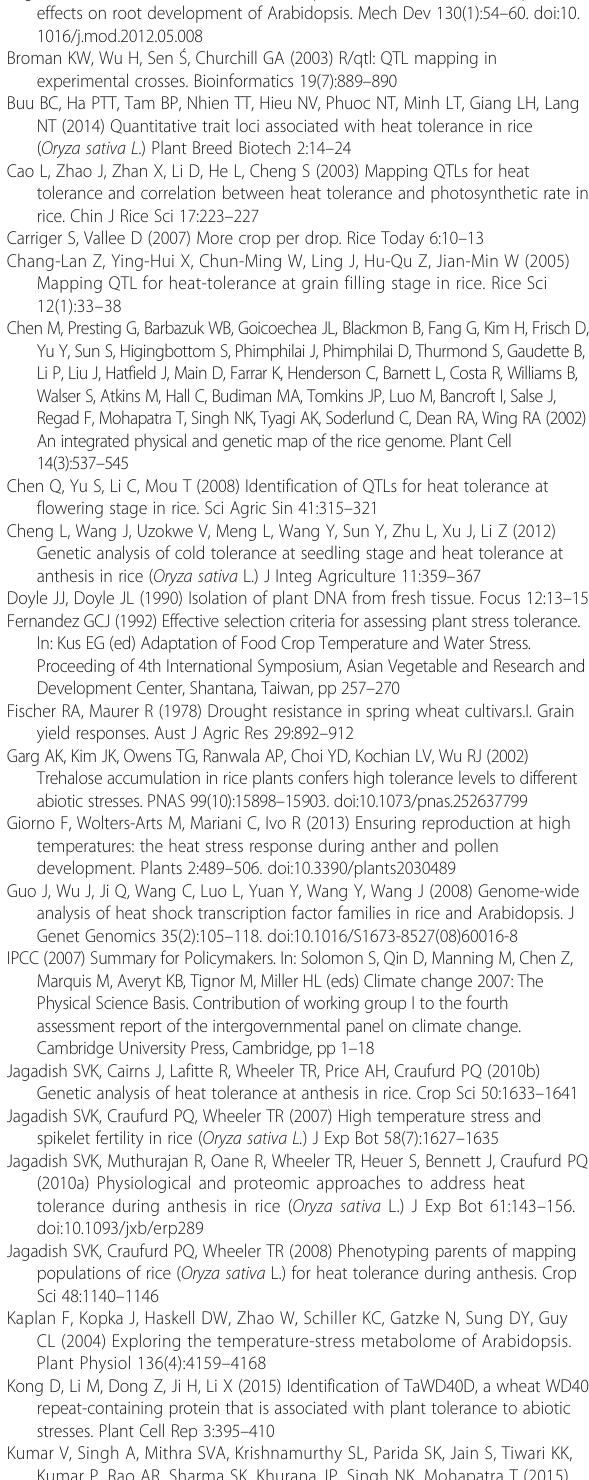
Table S3. Reported QTLs related to heat stress tolerance in rice. (XLSX 52